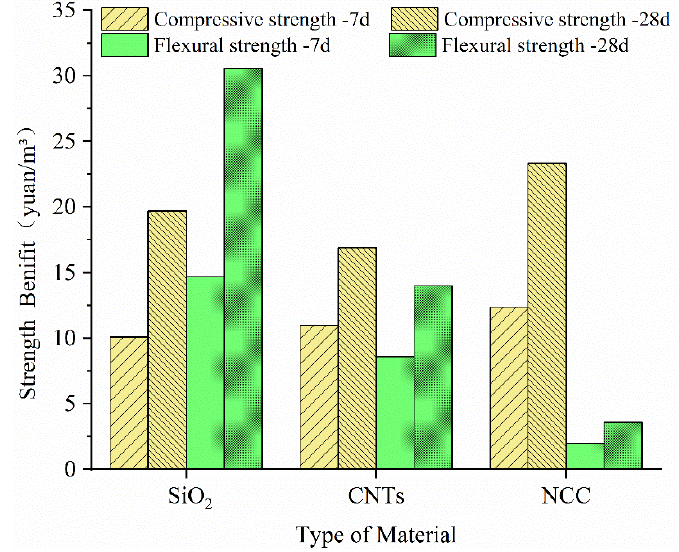
Figure 7. Compressive and flexural strength benefit of three nanomaterials.